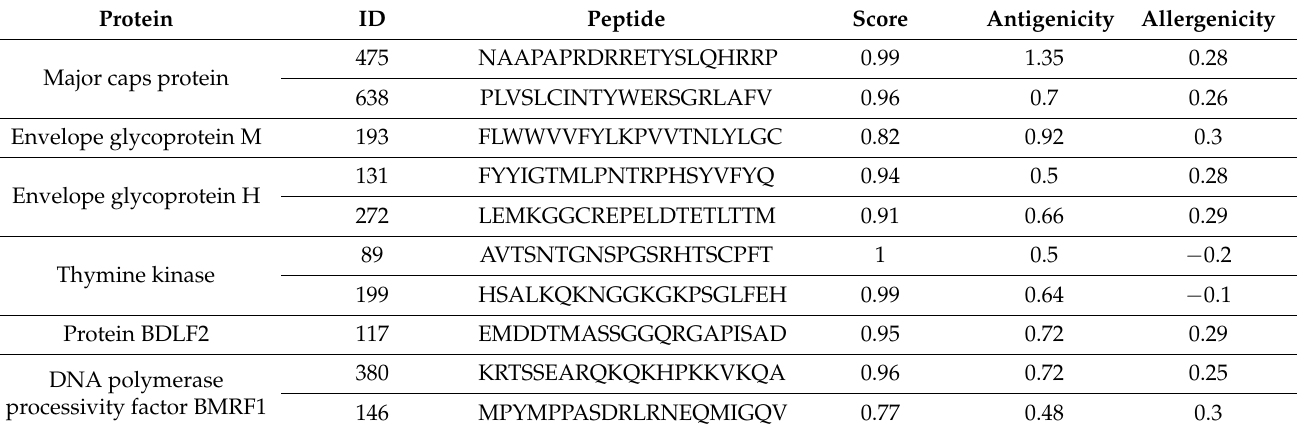
Table 4. Selected LBL epitopes with corresponding scores. Antigenic (>0.4) and non-Allergenic (<0.3).